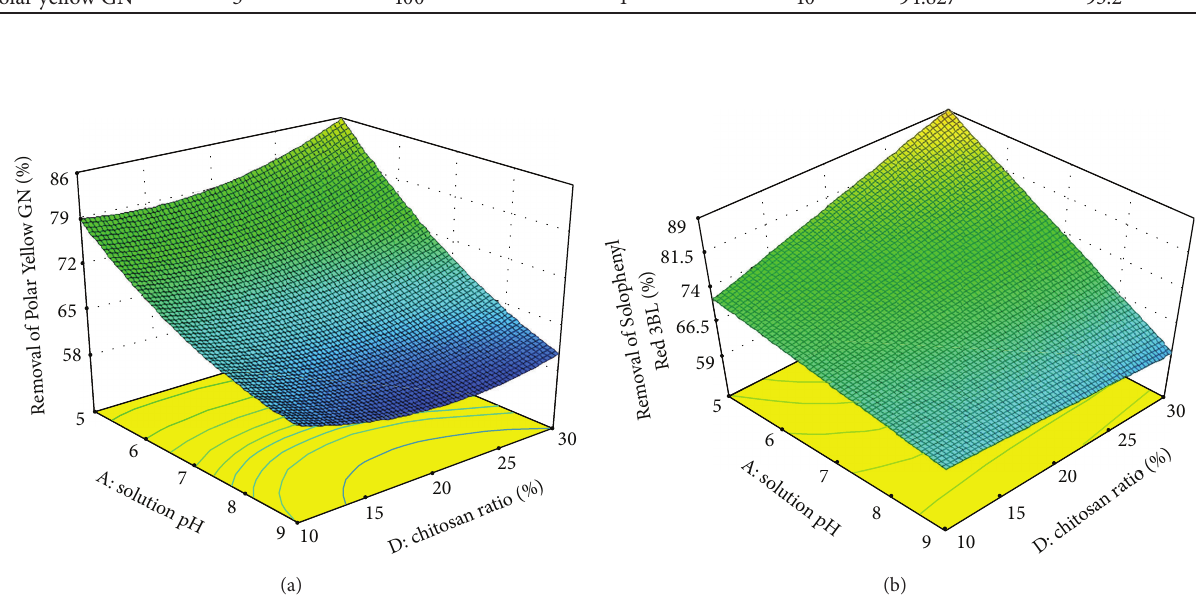
Figure 7: 3D surface plots of the dye removal for the chitosan ration and solution pH.